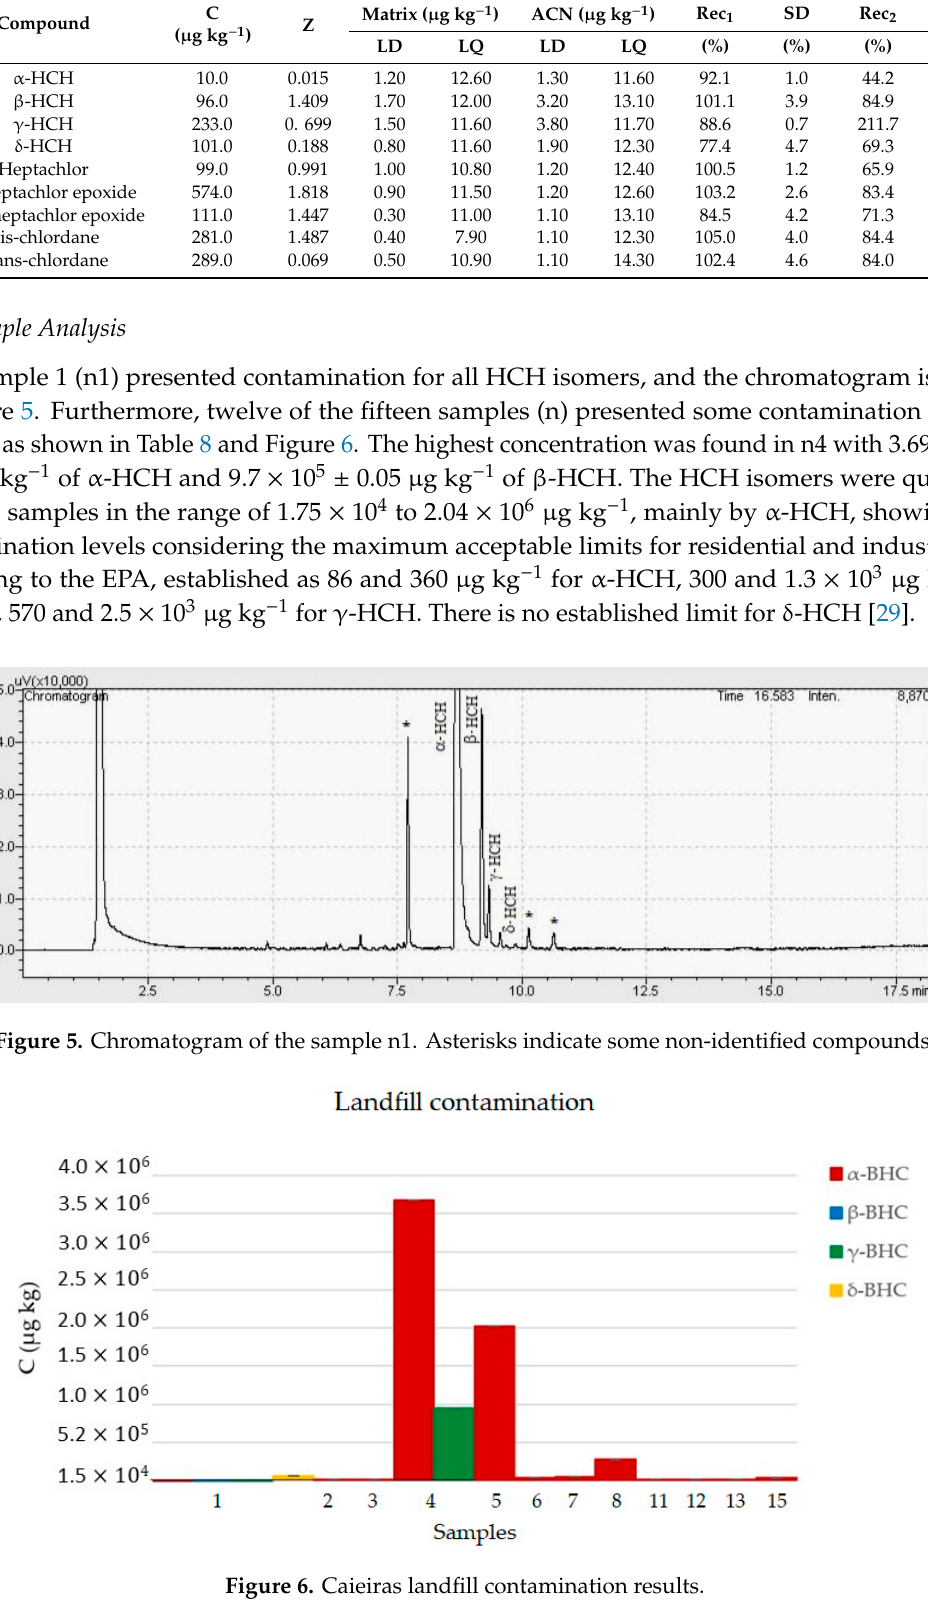
Table 7. Results of the score test (Z). Limits of detection (LD) and quantification (LQ) for solvent and matrix groups and recovery at soil fortification of 1.0 (Rec 1 ) and 2.0 µ g kg − 1 (Rec 2 ).